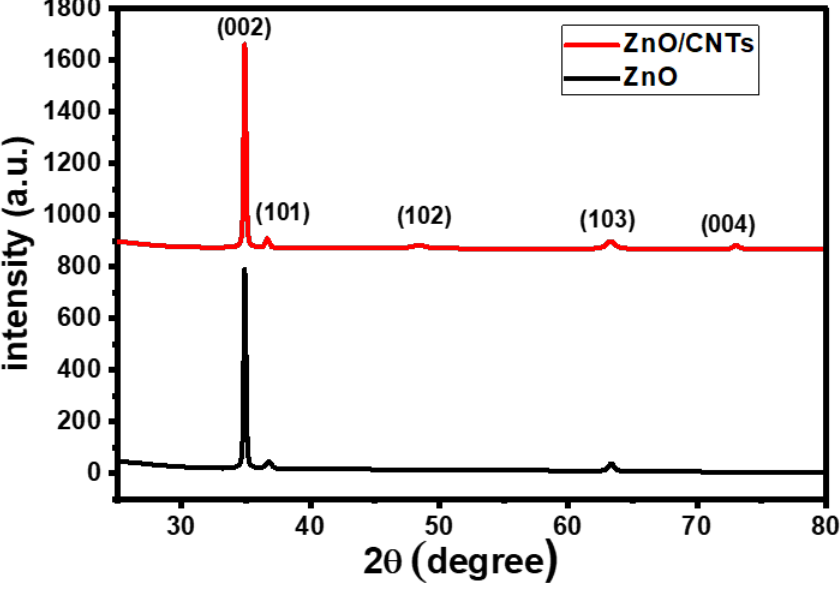
Figure 1. XRD for ZnO and ZnO/CNTs films.